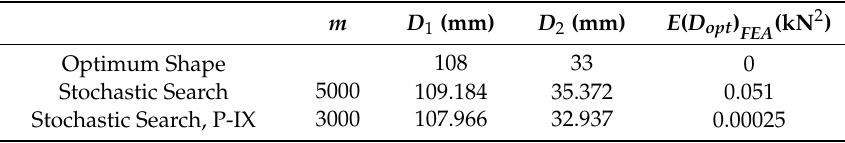
Table 10. Calculated cost function values in di ff erent design